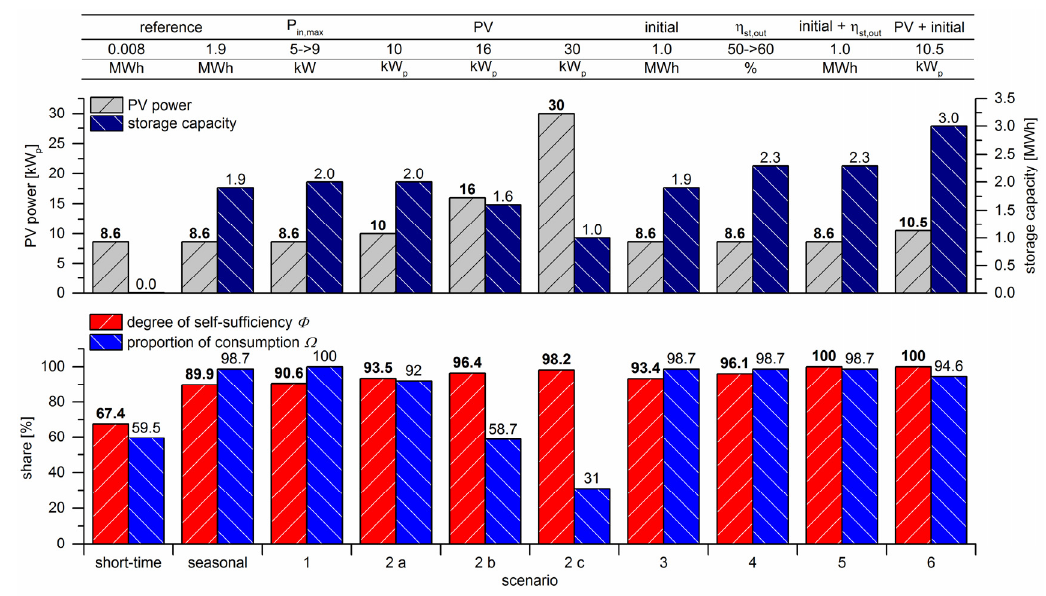
Figure 15. Different scenarios to achieve high degrees of self-sufficiency.